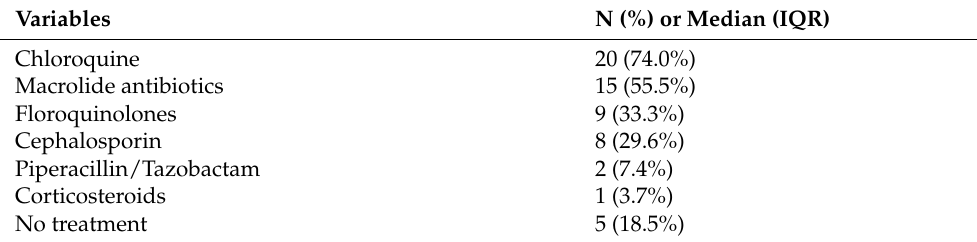
Table 3. The main medical treatment ( n = 27).